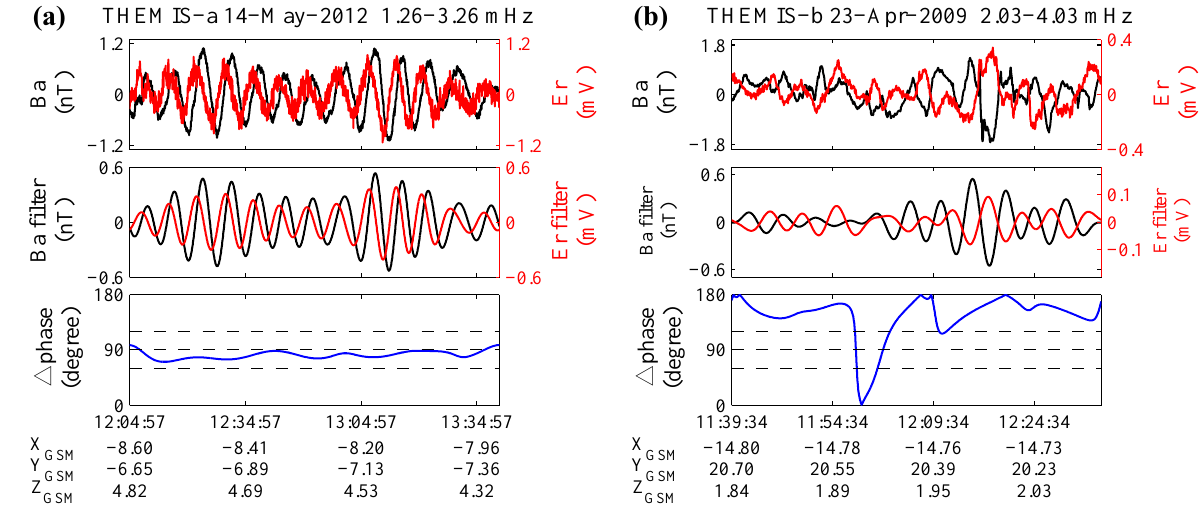
Figure 6. Examples of (a) a standing azimuthal oscillating event and (b) a non-standing azimuthal oscillating event.